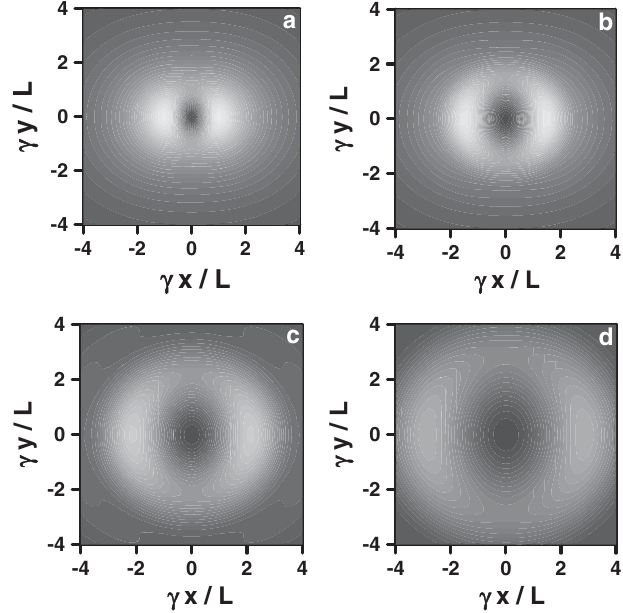
FIG. 4. TR 3D spatial distribution in the PWZ calculated for different distances from the target to the detector: (a) L (cid:5) 10 (cid:1) 2 (cid:2)= 2 (cid:3) (cid:5) 5 m (far-field zone), (b) L (cid:5) 2 (cid:1) 2 (cid:2)= 2 (cid:3) (cid:5) 1 m , (c) L (cid:5) 0 : 9 (cid:1) 2 (cid:2)= 2 (cid:3) (cid:5) 0 : 45 m , and (d) L (cid:5) 0 : 5 (cid:1) 2 (cid:2)= 2 (cid:3) (cid:5) 0 : 25 m . Calculation parameters: (cid:1) (cid:5) 2500 , (cid:2) (cid:5) 500 nm , a